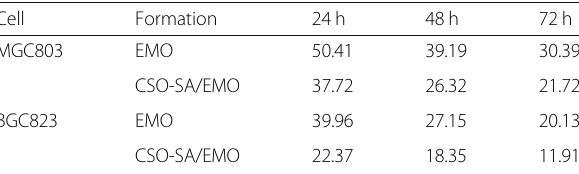
Table 2 The IC 50 values ( μ mol/L) of EMO and CSO-SA/EMO against gastric cancer cells Cell